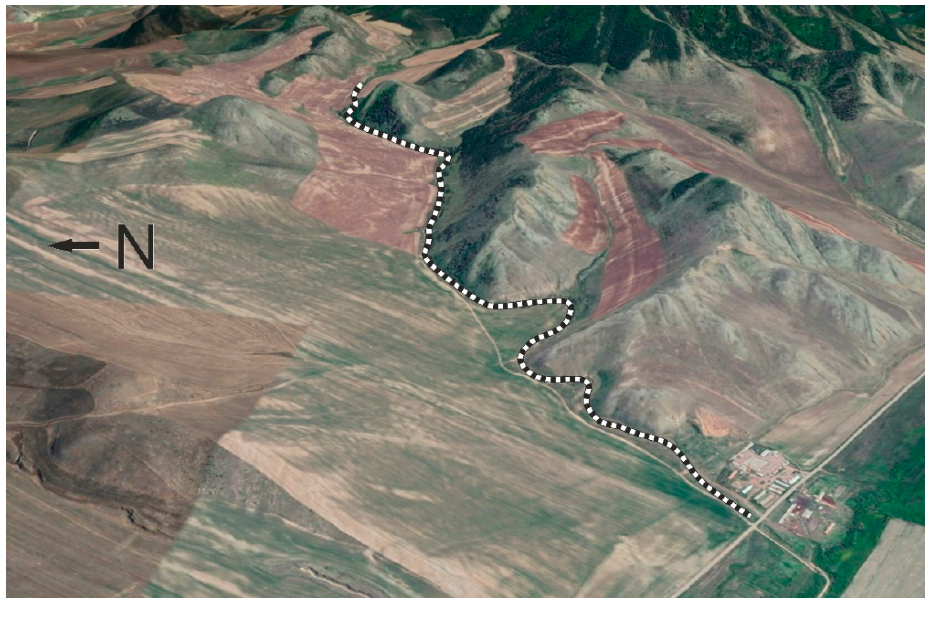
Figure 2. Three-dimensional view of the research area.